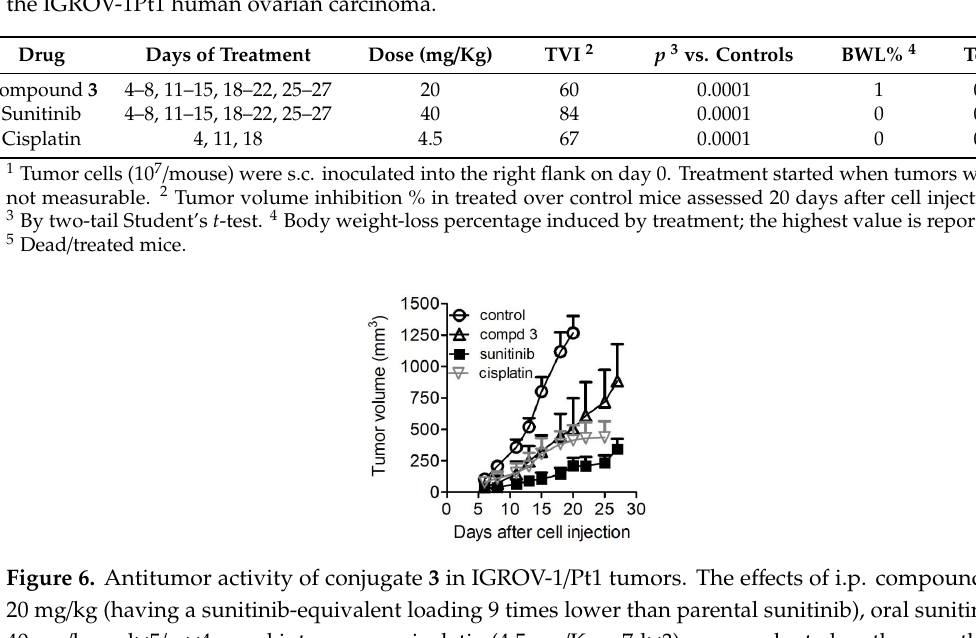
Table 1. Effects of i.p. compound 3 , oral sunitinib and intravenous cisplatin in nude mice s.c. bearing the IGROV-1Pt1 human ovarian carcinoma